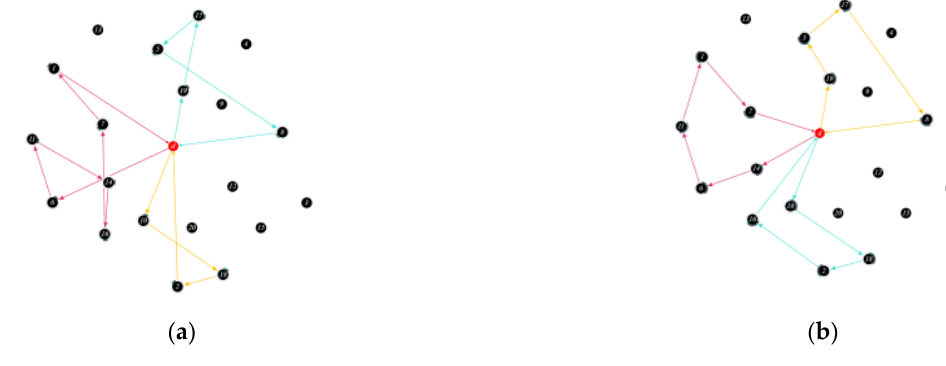
Figure 8. Planned routes: ( a ) distribution plan for serving customers respecting 1-h TW; ( b ) distribution plan for serving customers respecting 3-h TW.